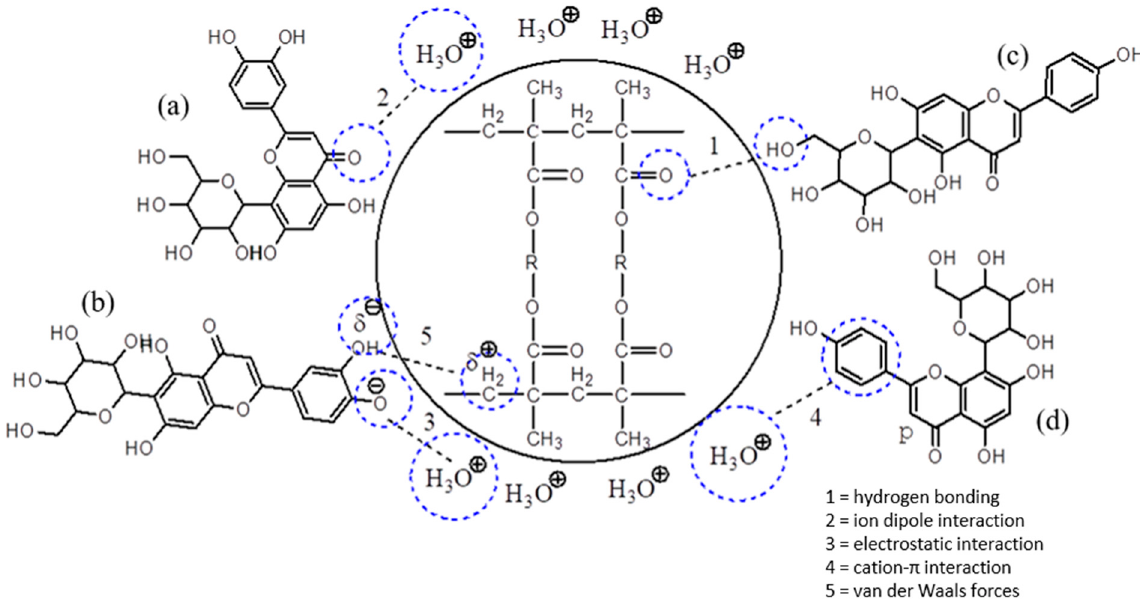
Figure 7. Schematic representation of the postulated interactions between targeted flavonoid C -glycosides for orientin ( a ), isoorientin ( b ), isovitexin ( c ), and vitexin ( d ) and the XAD7HP resin under acidic